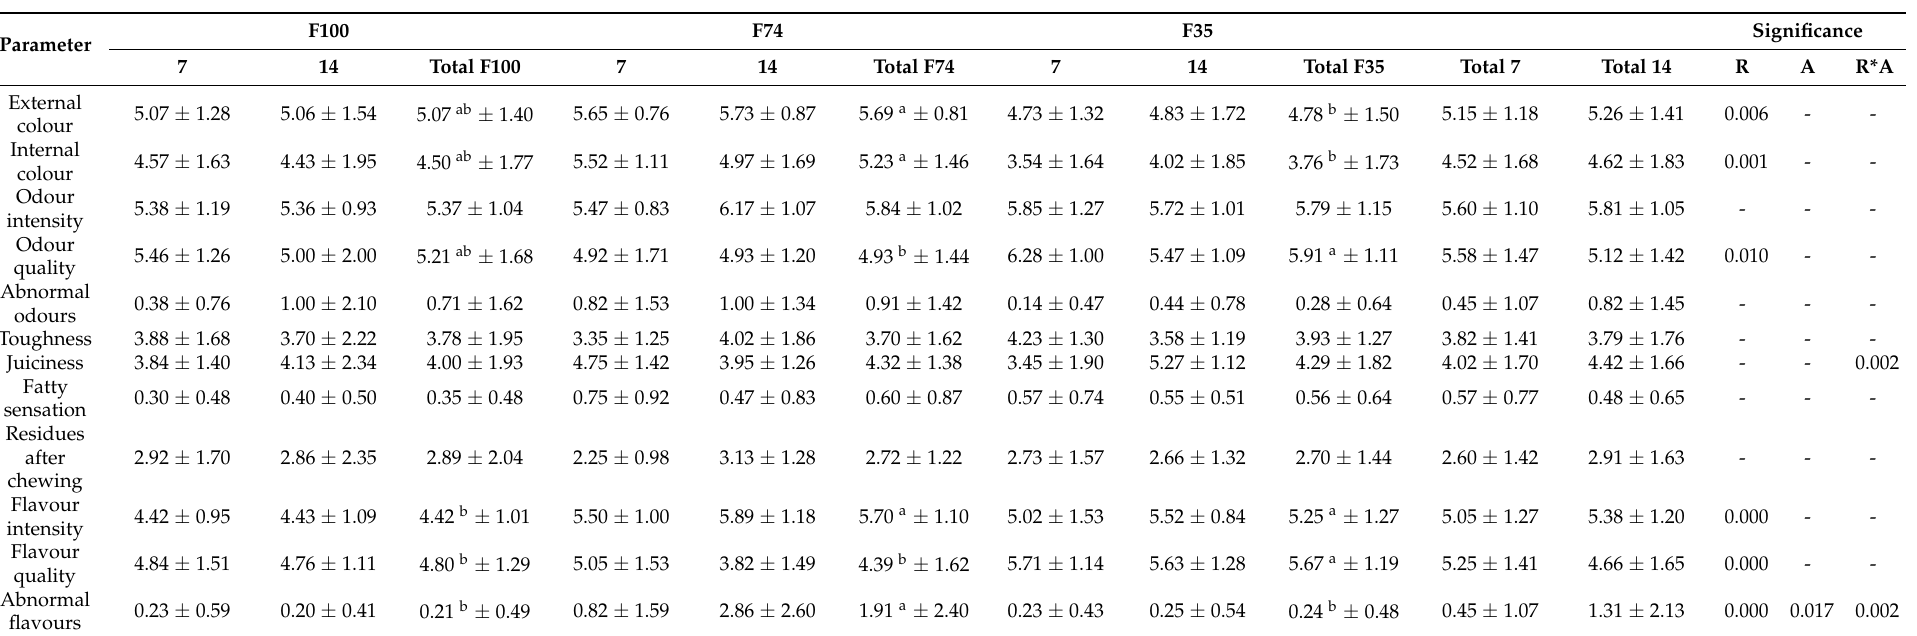
Table 4. Sensory attributes depending on the rearing system and ageing time (mean ±